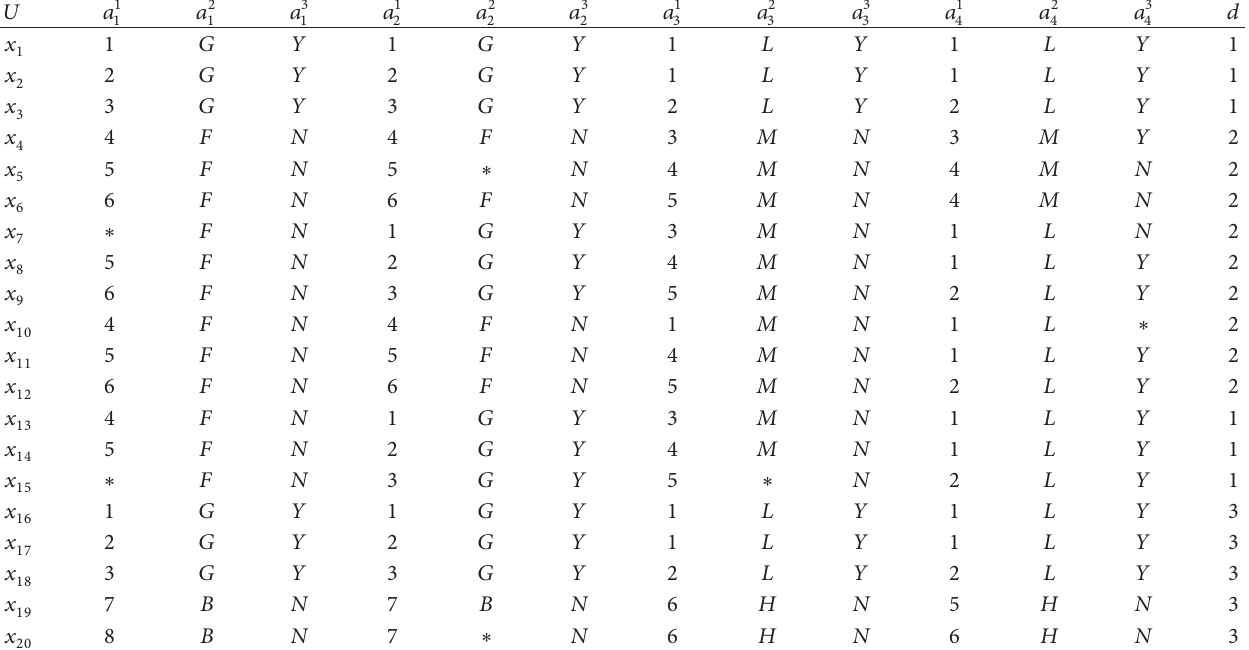
Table 1: An example of incomplete multiscale decision